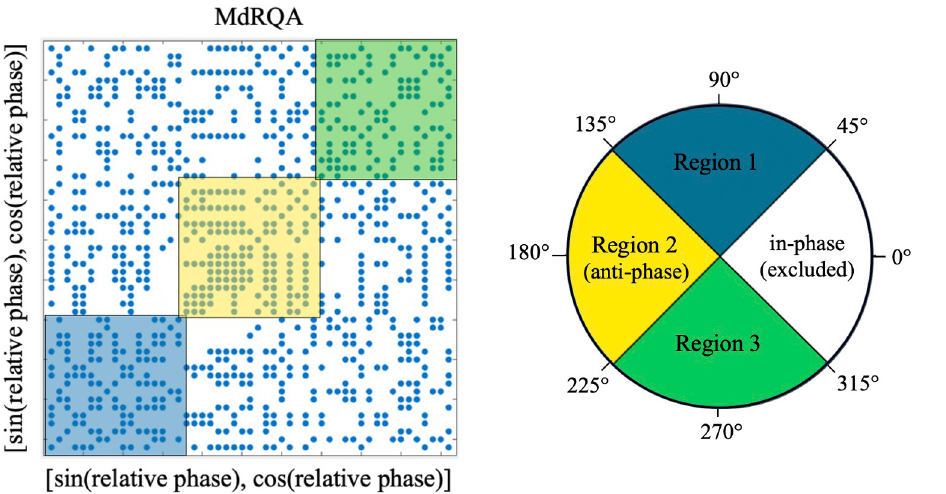
Fig 2. Sample multidimensional recurrence plot (MdRP) produced for one phasing trial. (A) How subsections were created from the MdRP to conduct region-based analysis. Each sample in the time series contains a vector of x - and y - coordinates of ψ . Recurrences or revisitations of the same multidimensional space (within a given tolerance) between the two time series (i.e., the same time series represented on the x -axis and y -axis) are plotted as points on the MdRP. (B) How participants’ taps were assigned to regions 1, 2, and 3 based on circular ψ values. As described in “Region-Based MdRQA,” synchronous taps were excluded from region-based MdRQA to effectively compare Successful and Unsuccessful